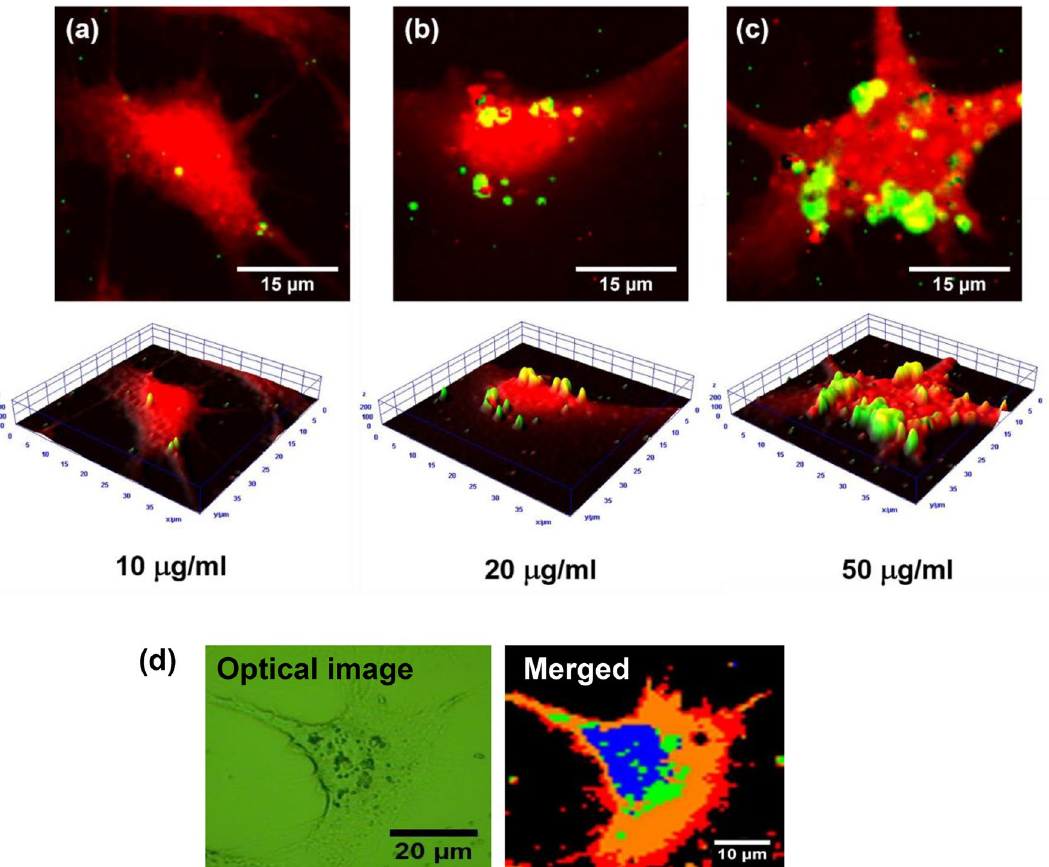
Figure 5. 2D and 3D Raman mapping of A549 cell after incubation for 4 h with various concentrations of ND@Au: ( a ) 10 µg/ml, ( b ) 20 µg/ml and ( c ) 50 µg/ml. For cell imaging Raman intensity spatial distribution in the range 2800–3100 cm −1 is mapped (shown in red); ND@Au is shown via ND Raman signal in the 1300– 1350 cm −1 range (green). ( d ) the reconstructed image of a Raman mapping from Principle Component Analysis (PCA) with K-means cluster analysis, shown the relative positions of each component, nucleus (blue), ND@Au (green), cytoplasm (red).